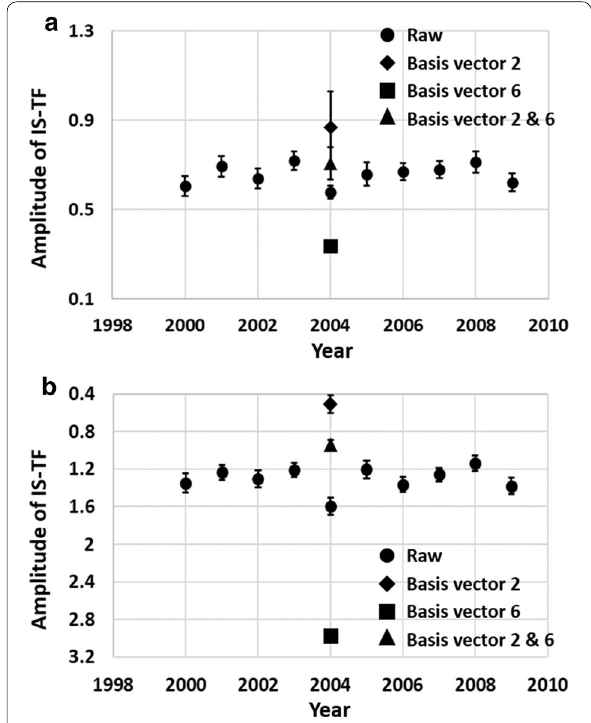
Fig. 10 Year‑to‑year changes in T yy between KNY and MMB at a frequency of 9/30,720 Hz. a T yy for KNY/MMB. The circles are derived from raw geomagnetic data, and correspond to the light‑blue dots in Fig. 7e. The diamonds/squares/triangles in 2004 are derived from the reconstructed data using only Basis vector 2/Basis vector 6/ Basis vectors 2 and 6, respectively. b T yy for MMB/KNY. The circles are derived from raw geomagnetic data, and correspond to the light‑blue dots in Fig. 7f. Note that the vertical axis of b is